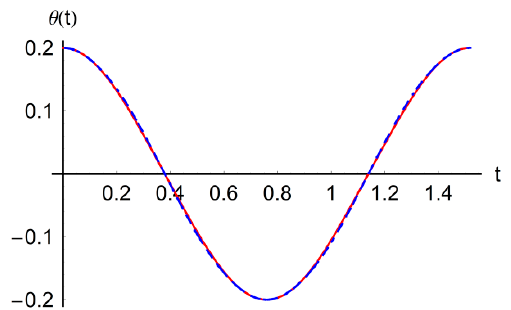
Figure 20. Comparison between the approximate solution (50) and numerical integration results for